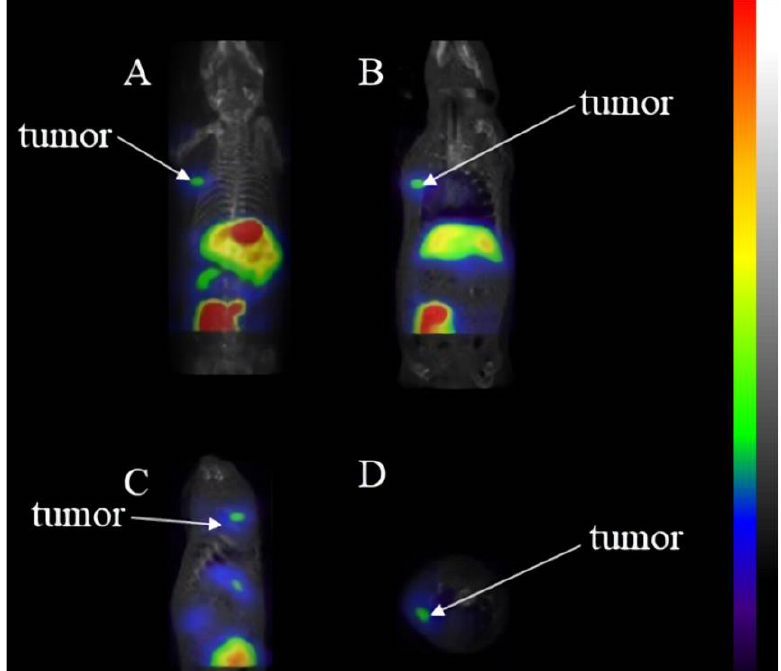
Figure 4. SPECT/CT images of [ 99m Tc]TcO-MOPADTC in mice bearing S180 cells at 4 h post-injection, visual imaging ( A ), coronal section ( B ), sagittal section ( C ) and transverse section ( D ).